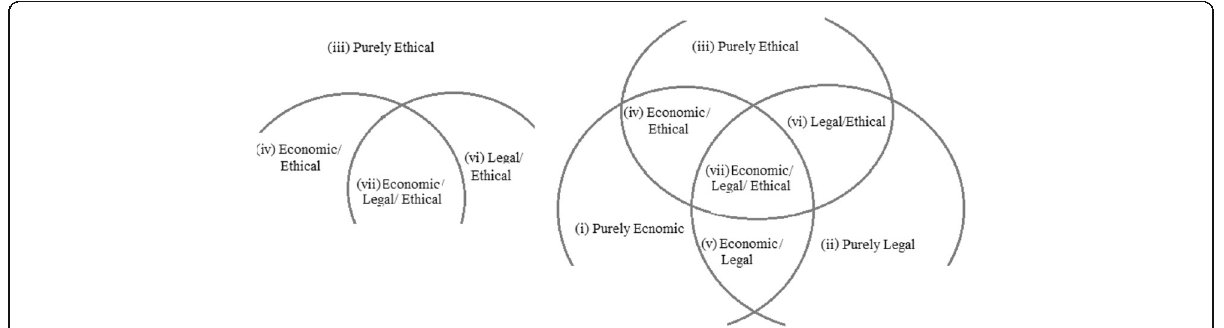
Fig. 5 The three-domain model of CSR. Source: Schwartz and Carroll (2003, p.